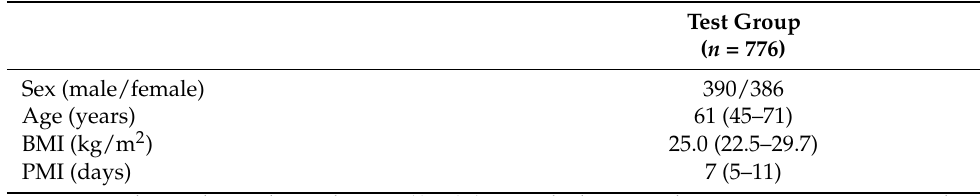
Table 2. Demographic overview of the test group used for the classification